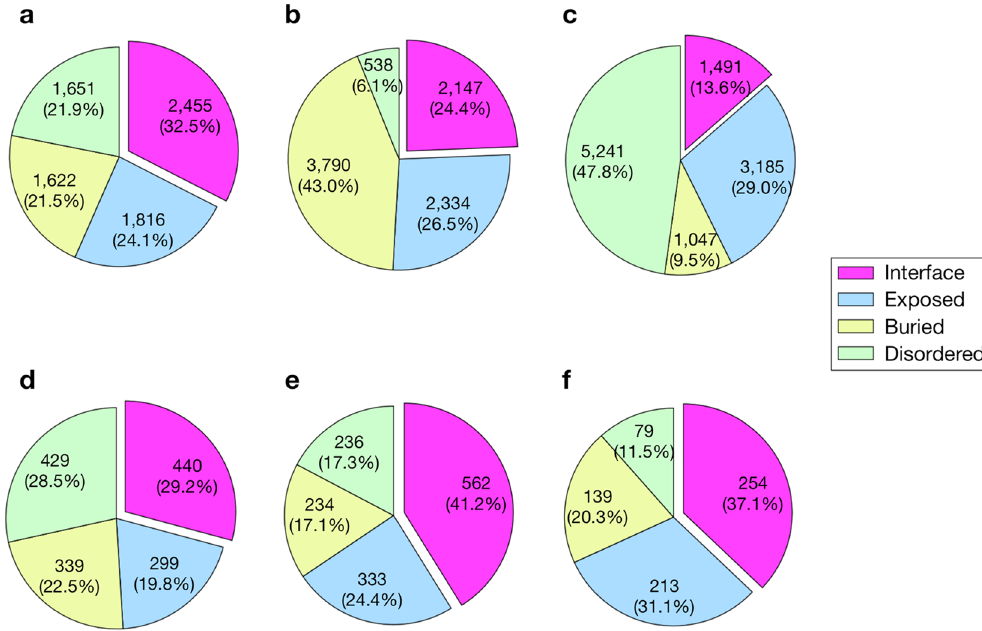
Figure 1. Locational distribution of mutation sites on protein structures. ( a – f ) Pie charts represent the distributions of missense mutations on the different structural regions, namely, molecular interface, buried, exposed, or disordered regions, for AD ( a ), AR ( b ), SNV ( c ), HI ( d ), DN ( e ), and GF ( f ).